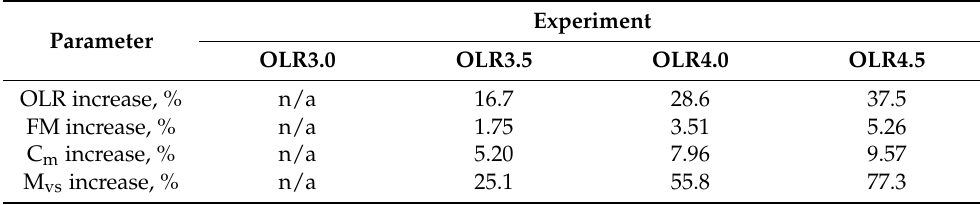
Table 3. Indicators of biogas production.